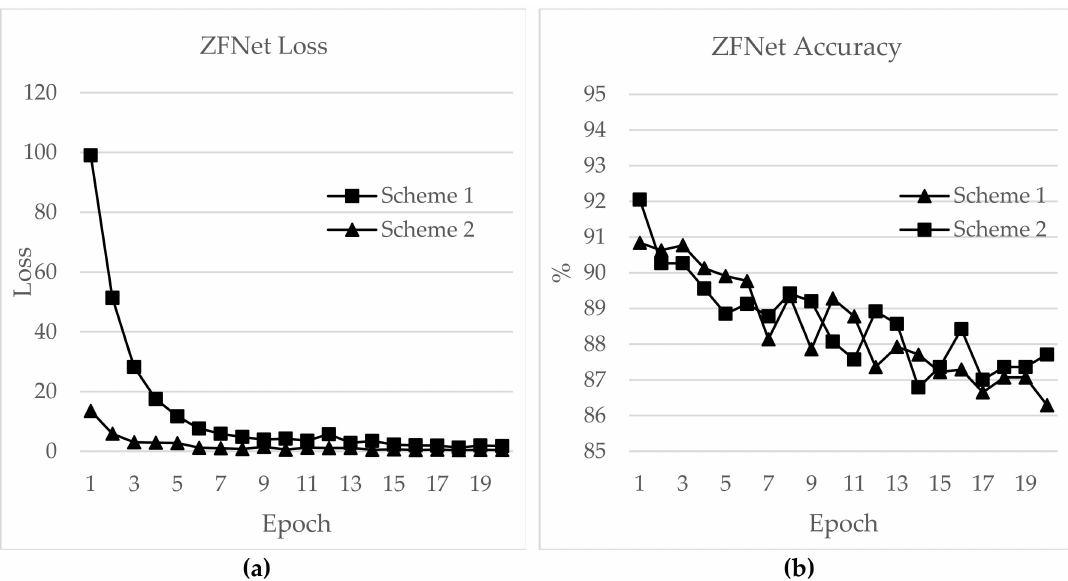
Figure 19. ZFNet ( a ) Loss curves ( b ) Accuracy curves.